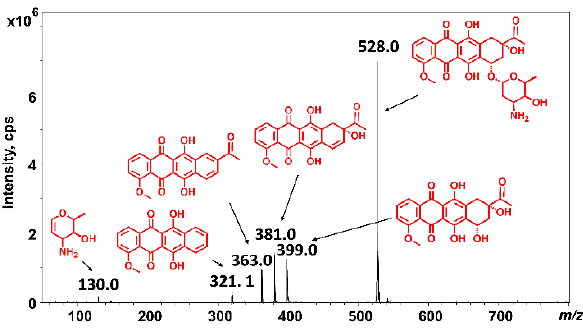
Figure 1. In-source fragmentation pattern of daunomycin ( m / z 528.0, [M + H] + ) under the commonly used electrospray ionization-mass spectrometry (ESI-MS) conditions. The structures correspond to the non-protonated molecules, and the protonation sites are not specified here.